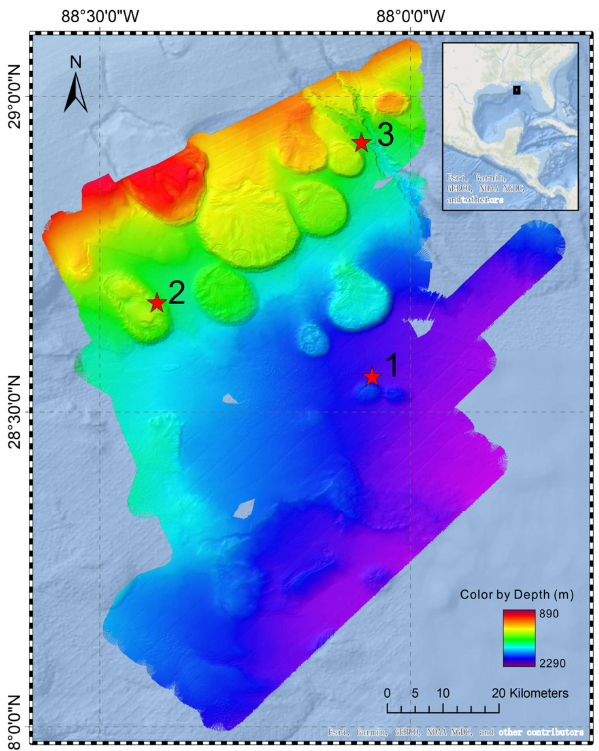
Figure 12. Geographical location of the experimental area.